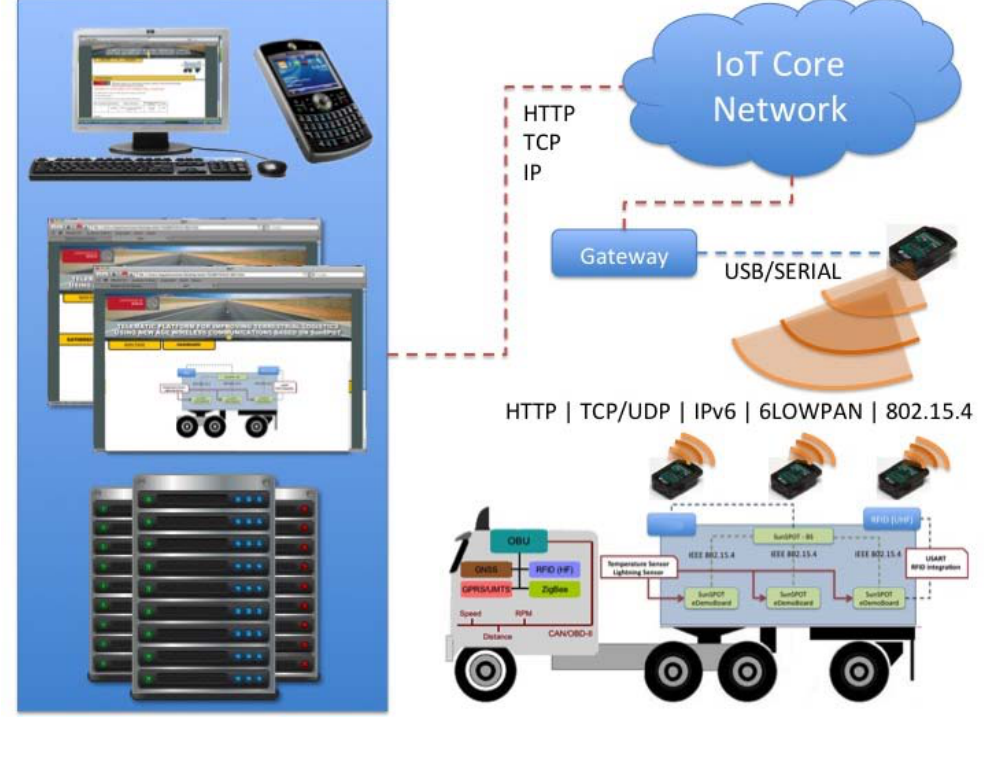
Figure 9. Schematic description of the different communication technologies used between